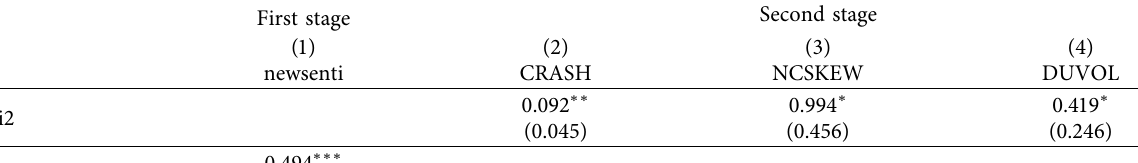
Table 17: Robust test: two stages OLS